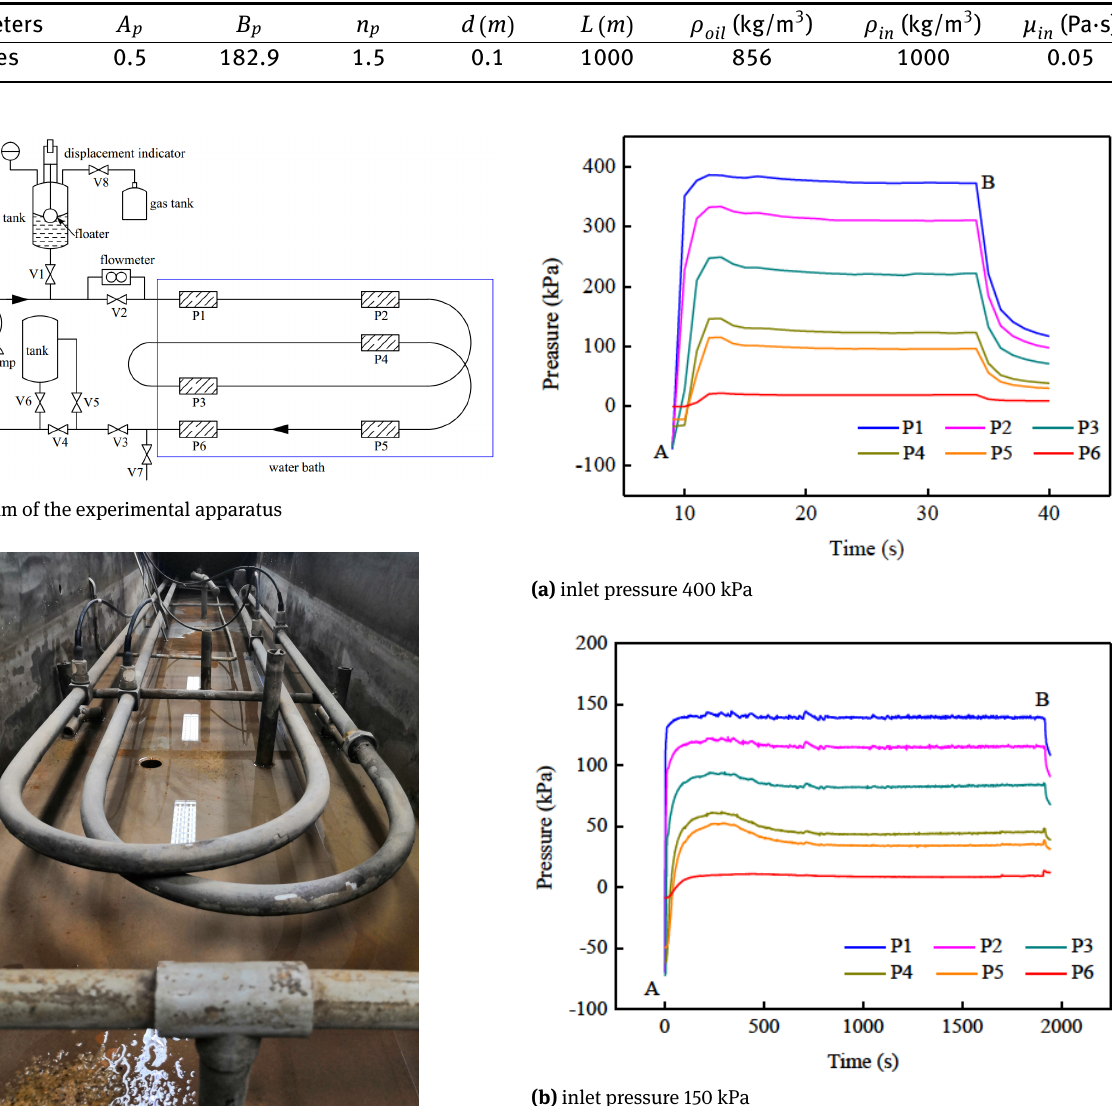
Table 6: The basic parameter values for calculation